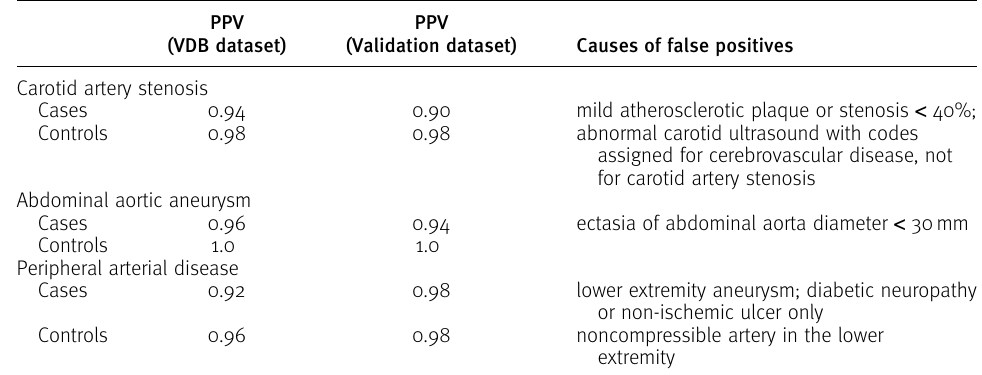
Table 4. Accuracy of electronic phenotyping algorithms – comparison of EMR-based algorithms to manual medical record review in cases ( n 5 50) and controls ( n 5 50) in each